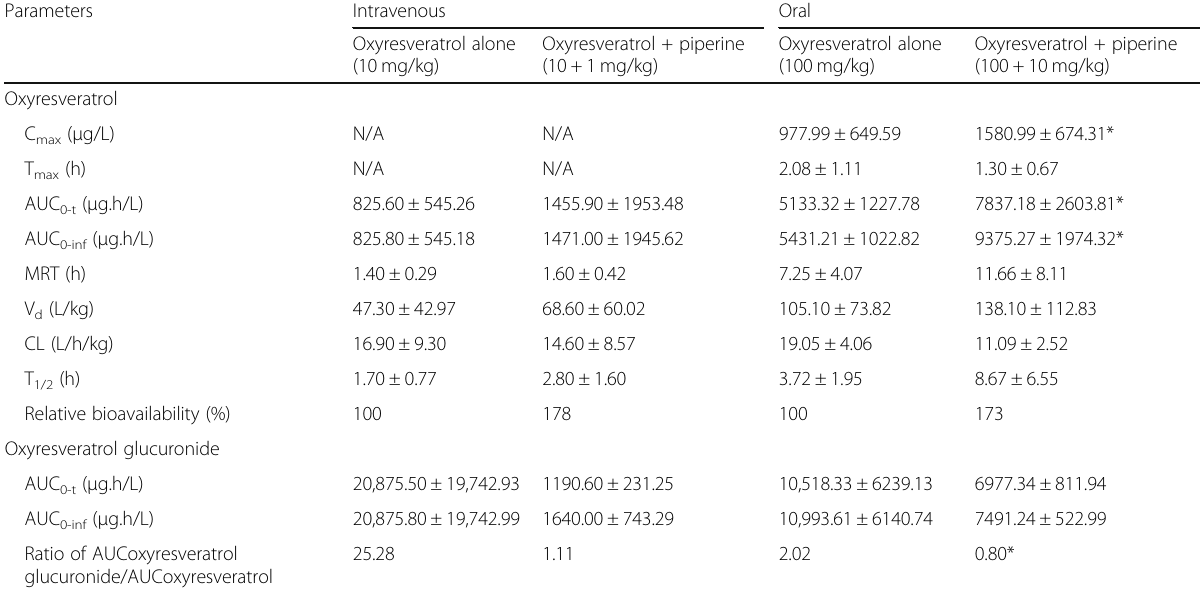
Table 2 Pharmacokinetic parameters of oxyresveratrol alone and in combination with piperine